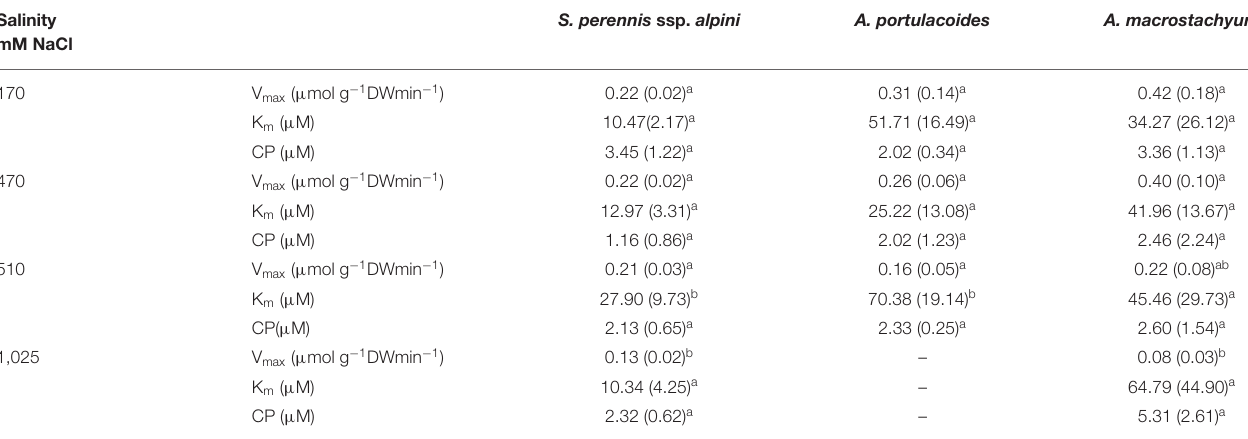
TABLE 3 | Kinetic parameters of nitrate uptake curves measured at different salinities in the three species of this study. Salinity mM NaCl